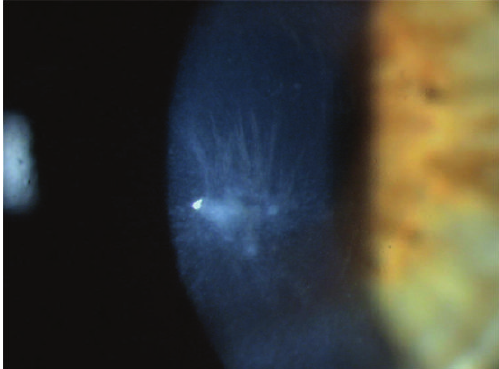
Figure 4: RE biomicroscopy showing hyperplasic epithelial nodule in the central region of the cornea as well as discreet anterior stromal striae.